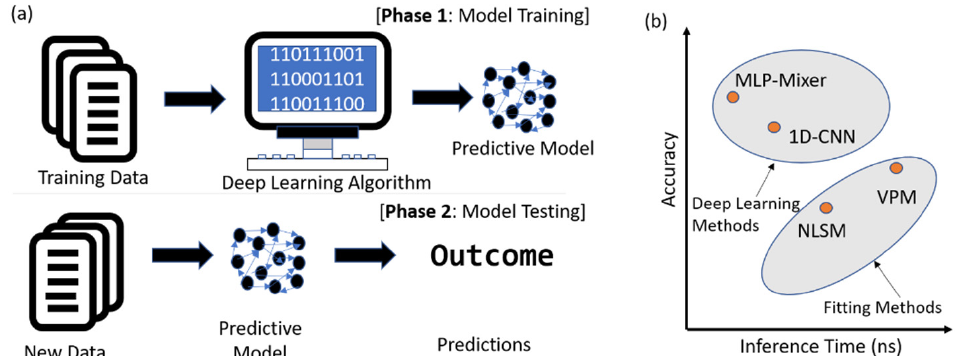
Figure 1. ( a ) Logic of the deep learning algorithm based on a predictive model considering training and testing phases. ( b ) Comparison of fluorescence lifetime prediction methods related to inference time and accuracy for one FLIM image.